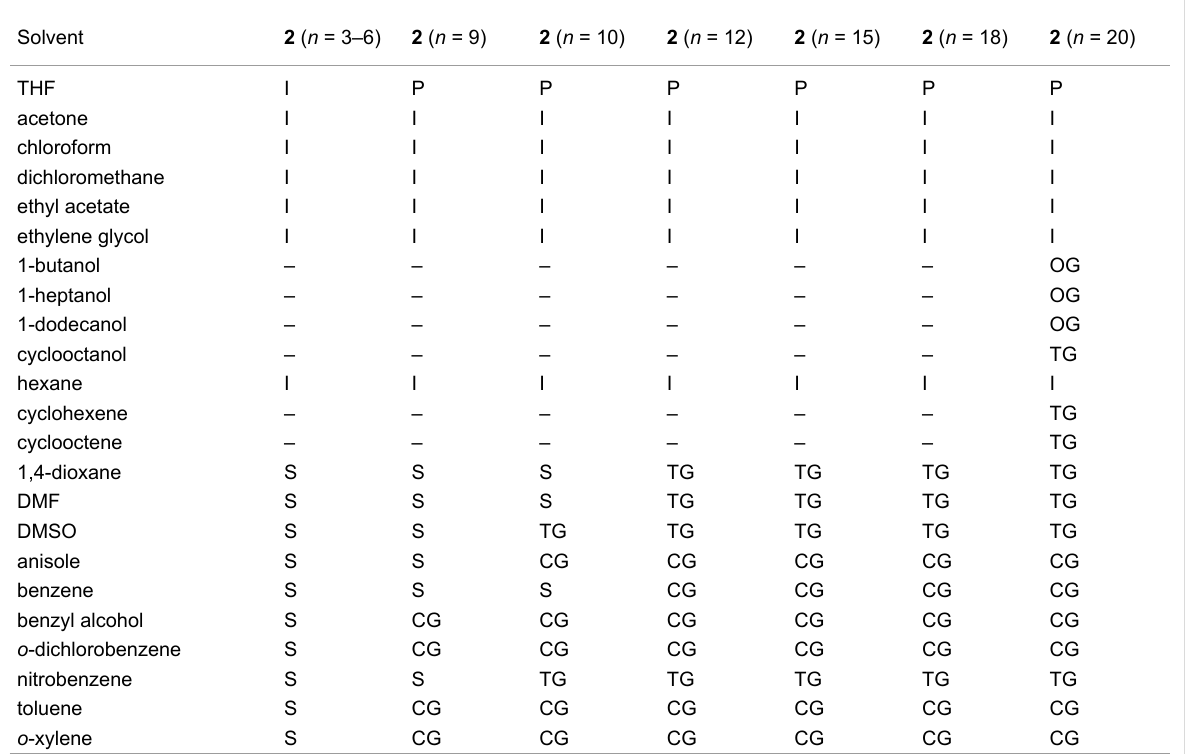
Table 1: Gelation behavior of bis( N -alkylurea valine) compounds 2 at 2% w/v a .